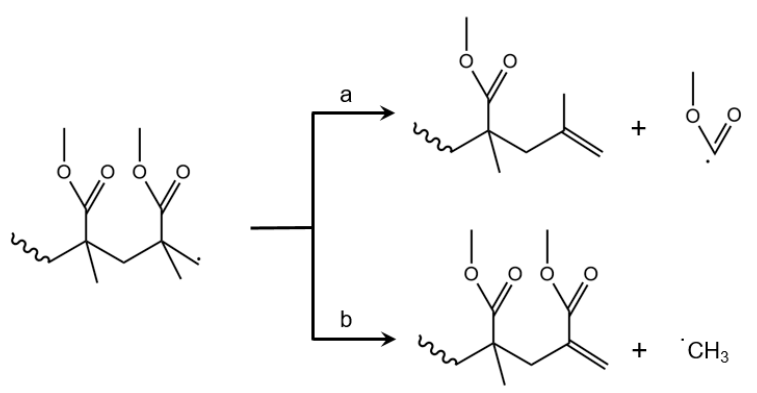
Figure 15. ( a ) Side-group β -scission of the primary radical formed during H-T fission as covered in Section 3.1 (“third” type of β -scission); ( b ) alternative leading to methyl radical formation as proposed in the theoretical research of Stoliarov et al. [74] .